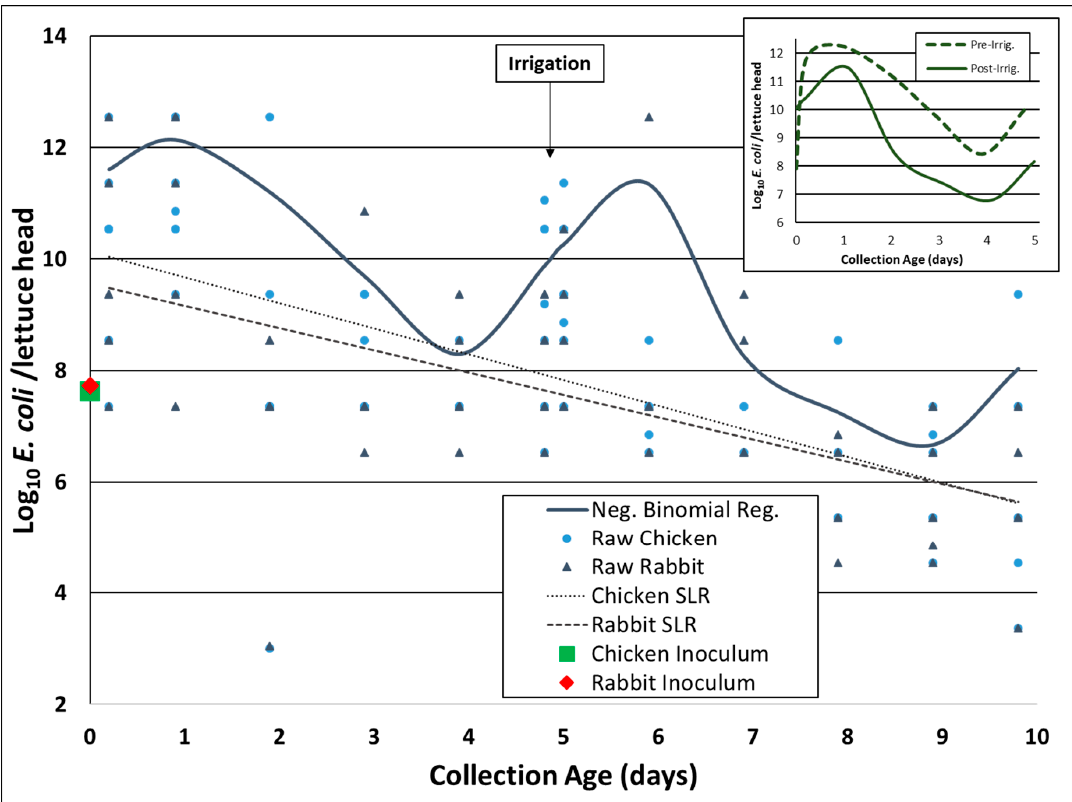
r on Romaine heads of